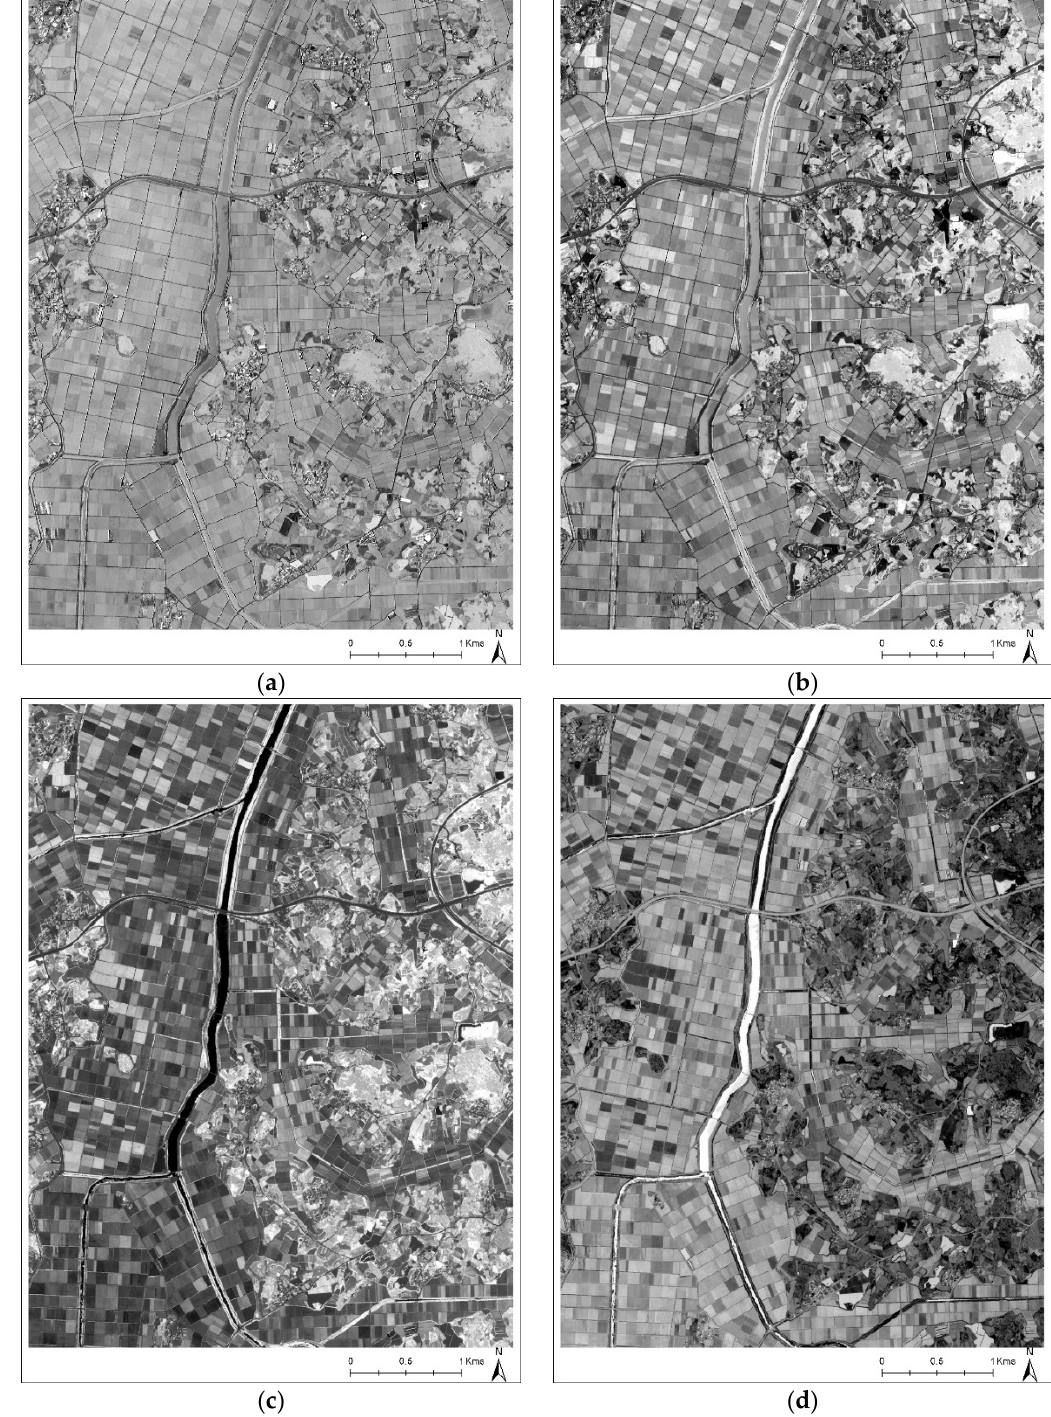
Figure 4. Example of derived ratio and indices from KOMPSAT ‐ 3A bands in the study area: ( a ) Blue/Green; ( b ) Green/Red; ( c ) Normalized Difference Vegetation Index (NDVI); and ( d ) Normalized Difference Water Index (NDWI). Compositing these bands could provide better classification information for original bands.